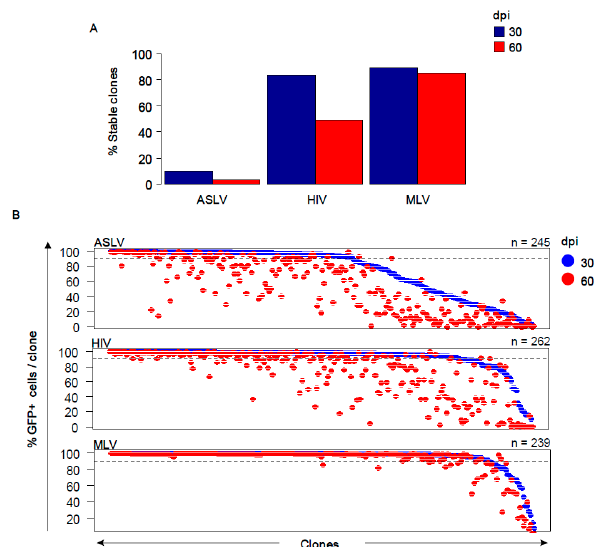
Figure 2. Differential expression stability of vectors. ( A ) The percentage of clones with stable active proviruses ( ≥ 90% GFP + cells) at 30 dpi (blue columns) and 60 dpi (red columns). 100% represents the number of clones obtained after single-cell sorting of GFP + cells 3 dpi. ( B ) The percentage of GFP + cells in single-cell clones analysed at 30 and 60 dpi. Each clone is represented by one blue (30 dpi) and one red (60 dpi) dot at the same position along the x-axis. In most cases, the red dot is lower along the y -axis than the blue dot, which represents the silencing of GFP expression between 30 and 60 dpi. Along the x -axis, clones are ordered by the percentage of GFP + cells at 30 dpi. The dashed line marks the value of 90% of GFP + cells. The numbers of clones analysed up to 60 dpi are